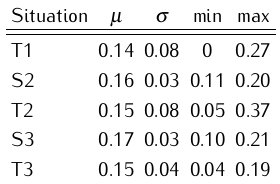
Table 7. The average speaking time (fraction of time) for the researcher (R) and the participants (P) during T1-T3 and S2-S3. The number is given as a percentage of the total time in each